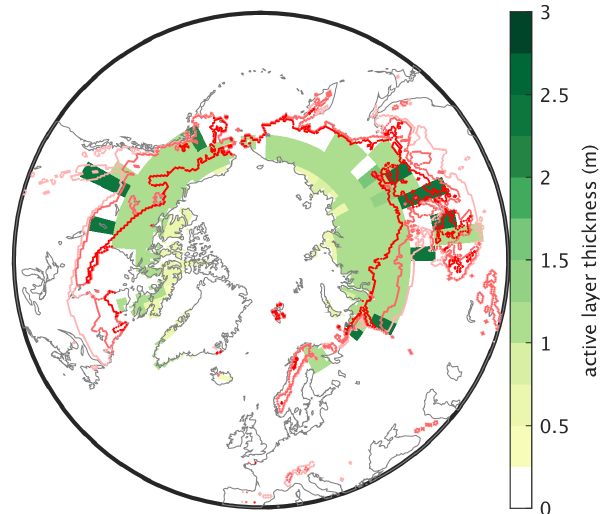
Figure 18. Modelled permafrost extent and active layer thickness compared to the observed extent of continuous, discontinuous, and isolated permafrost (red lines, from dark red to light red) from Brown et al. (1998). The active layer thickness is calculated as the mean over the period 1981–2010 in grid cells that are permafrost during the whole time